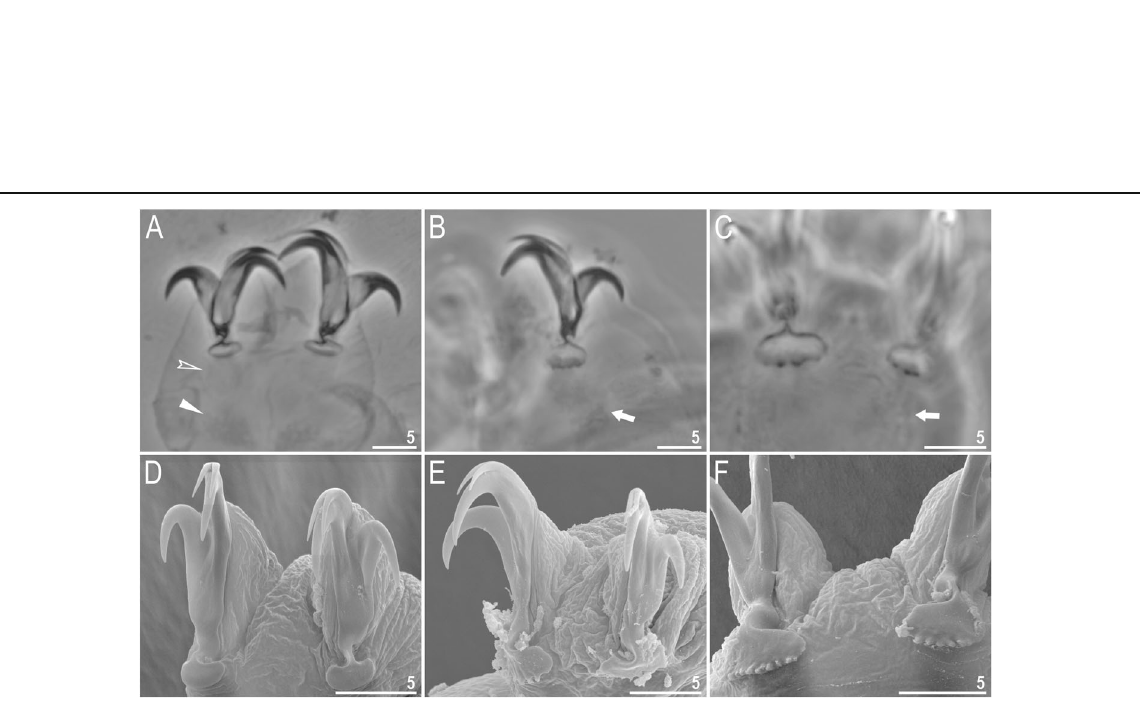
Fig. 15 Macrobiotus pseudopallarii sp. nov. from Montenegro (ME.007) – claw morphology: a – b – claws III and IV seen with LCM; C – magnification of lunulae IV seen with LCM; d – e – claws III and IV seen with SEM; f – magnification of lunulae IV seen with SEM. Empty-indented arrowheads indicate dark circular areas under lunulae on the first three pairs of legs, filled flat arrowheads indicate cuticular bars above muscle attachments, and arrows indicate horseshoe structures connecting the anterior and posterior claws. Scale bars in μ